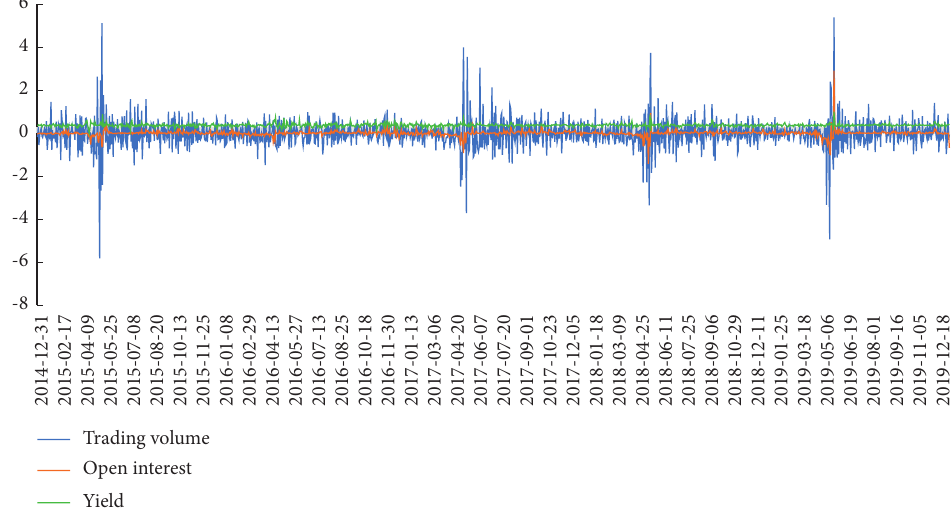
Figure 2: The volatility curve of trading volume, open interest, and